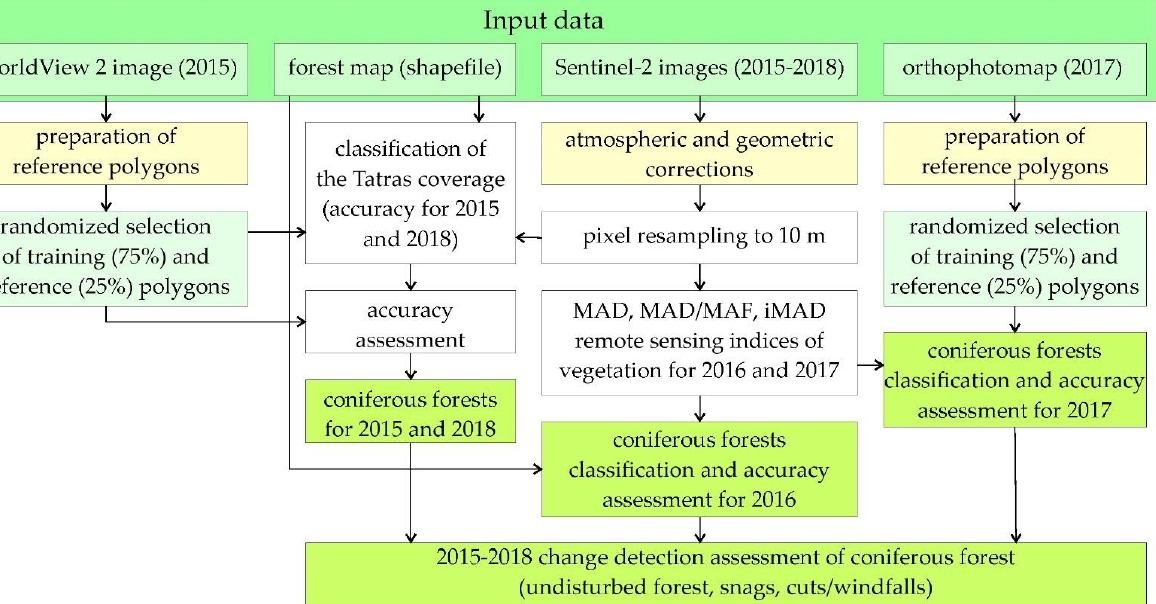
Table 2. Number of reference polygons and pixels between 2015 and 2017 used for change detec- tion.